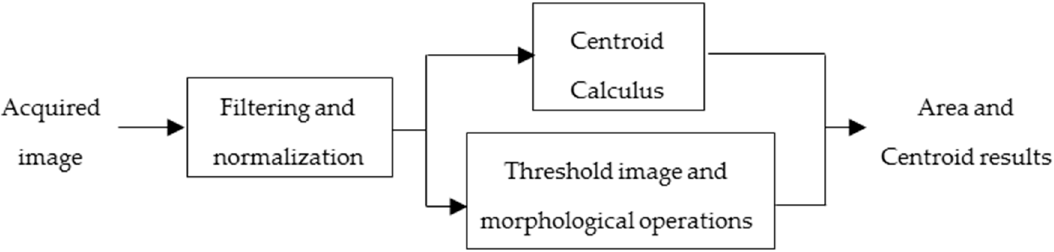
Figure 1. Signal processing scheme to register characteristics of beam centroid on an electronic embedded system. Source: Authors.